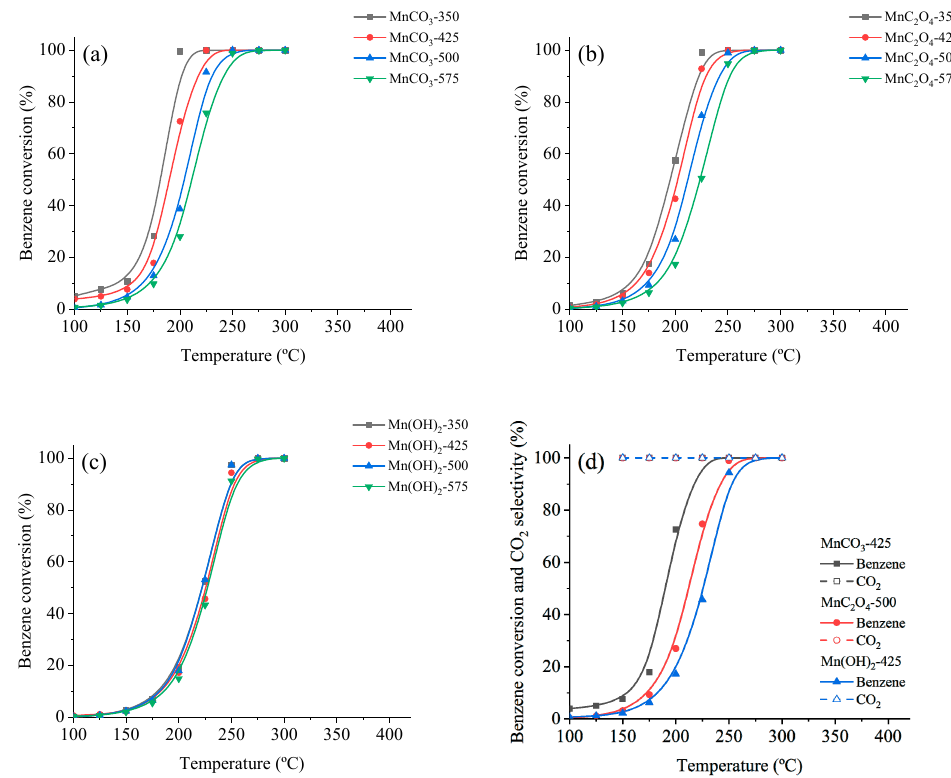
Figure 2. Catalytic evaluation of manganese oxide catalysts obtained by calcining ( a ) MnCO 3 , ( b ) MnC 2 O 4 and ( c ) Mn(OH) 2 for the benzene oxidation. ( d ) Benzene conversion and CO 2 selectivity of the MnCO 3 -425, MnC 2 O 4 -500 and Mn(OH) 2 -425 catalysts as a function of the temperature. (1000 ppm benzene / 20 vol.% O 2 / N 2 ; 200 mg catalyst; WHSV 30,000 mL · g − 1 · h − 1 ).